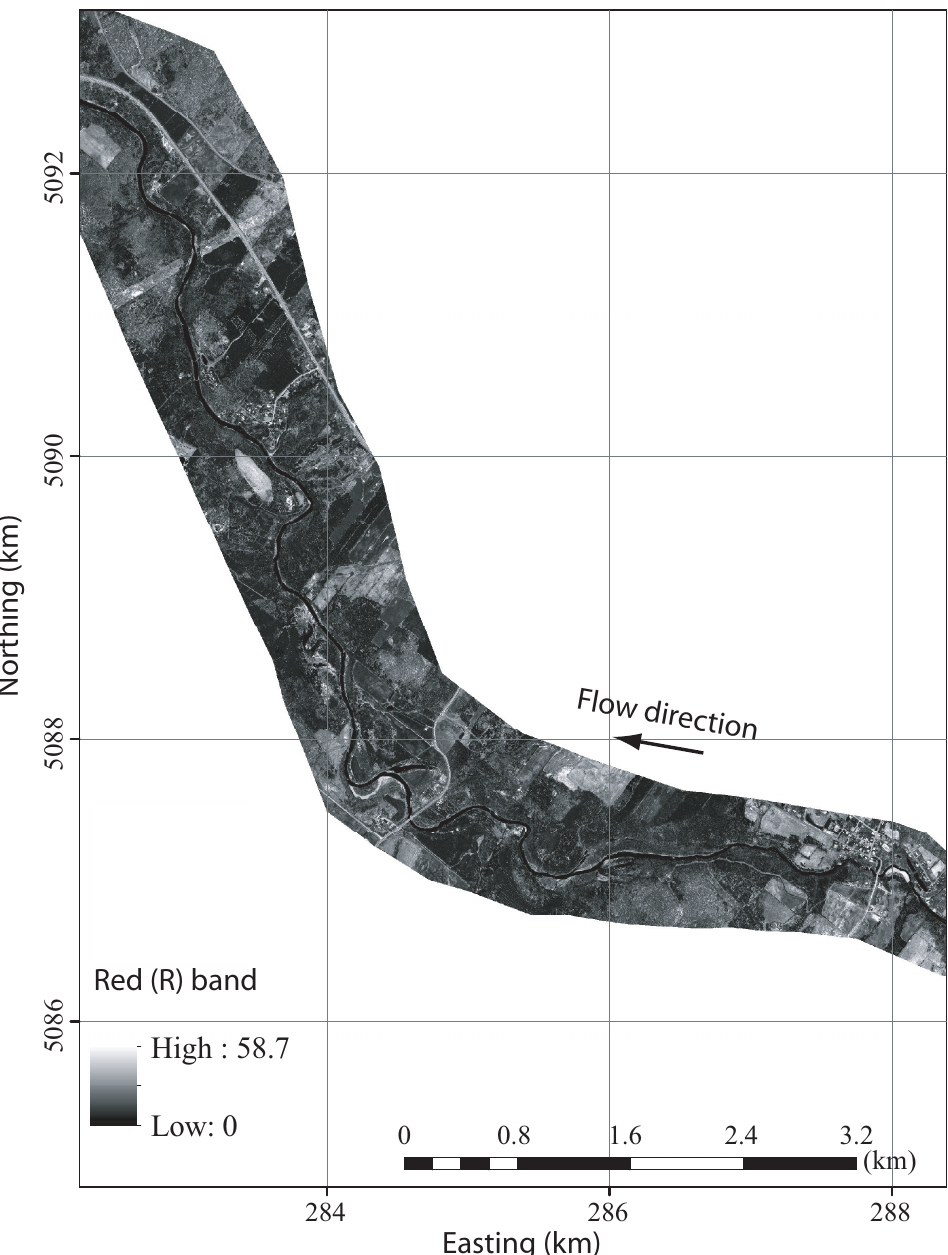
Figure A8. Corrected radiance in the red (R)